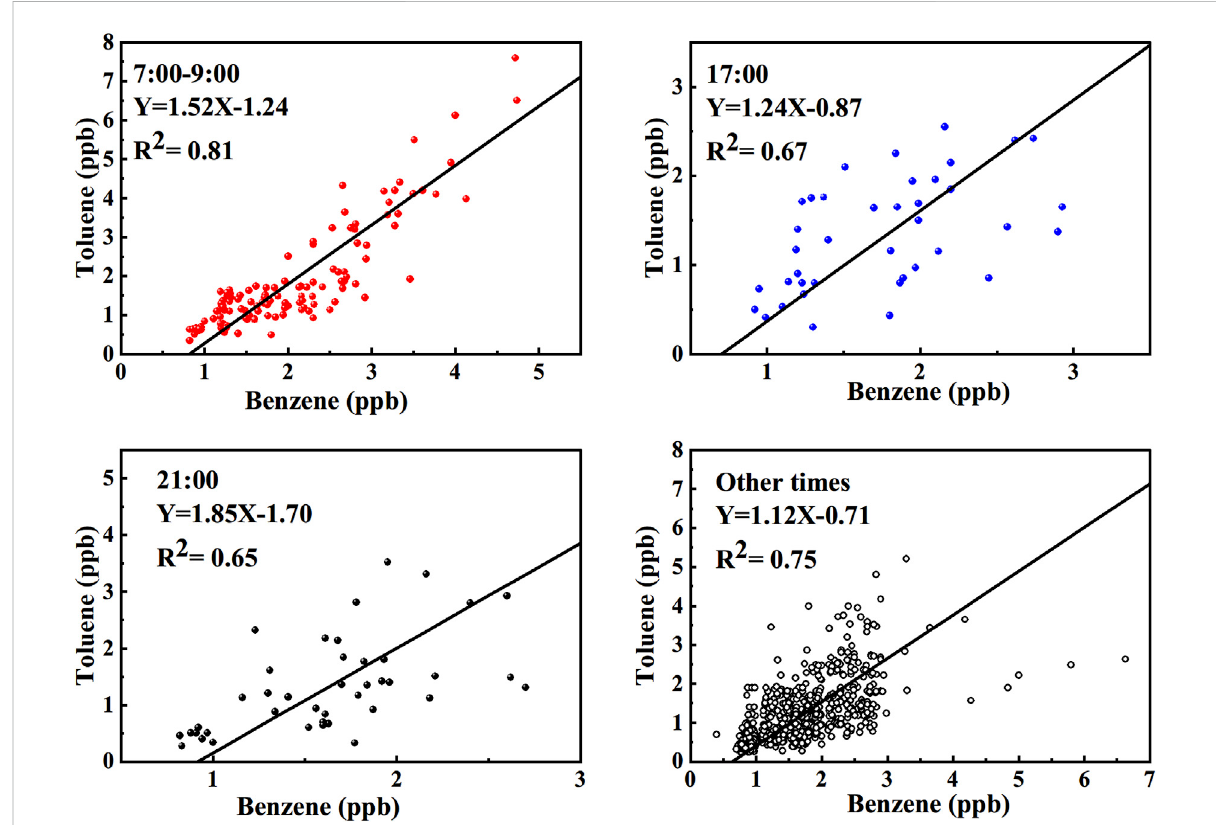
Correlations between benzene and toluene at distinct time periods ( p <